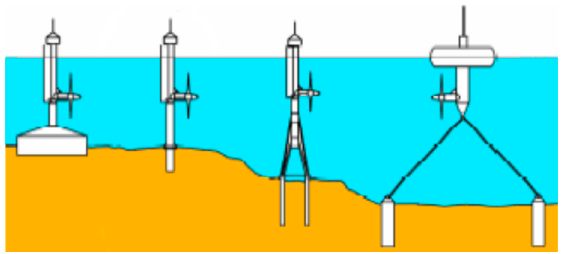
Figure 8. Marine current devices, axial rotor and cross flow.